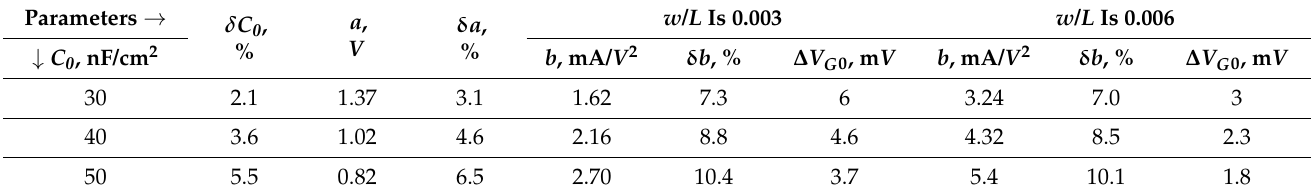
Table 3. Average values of parameters for different C 0 and ( w / L ) at I D is 0.1 mA and V D is 0.2 V.